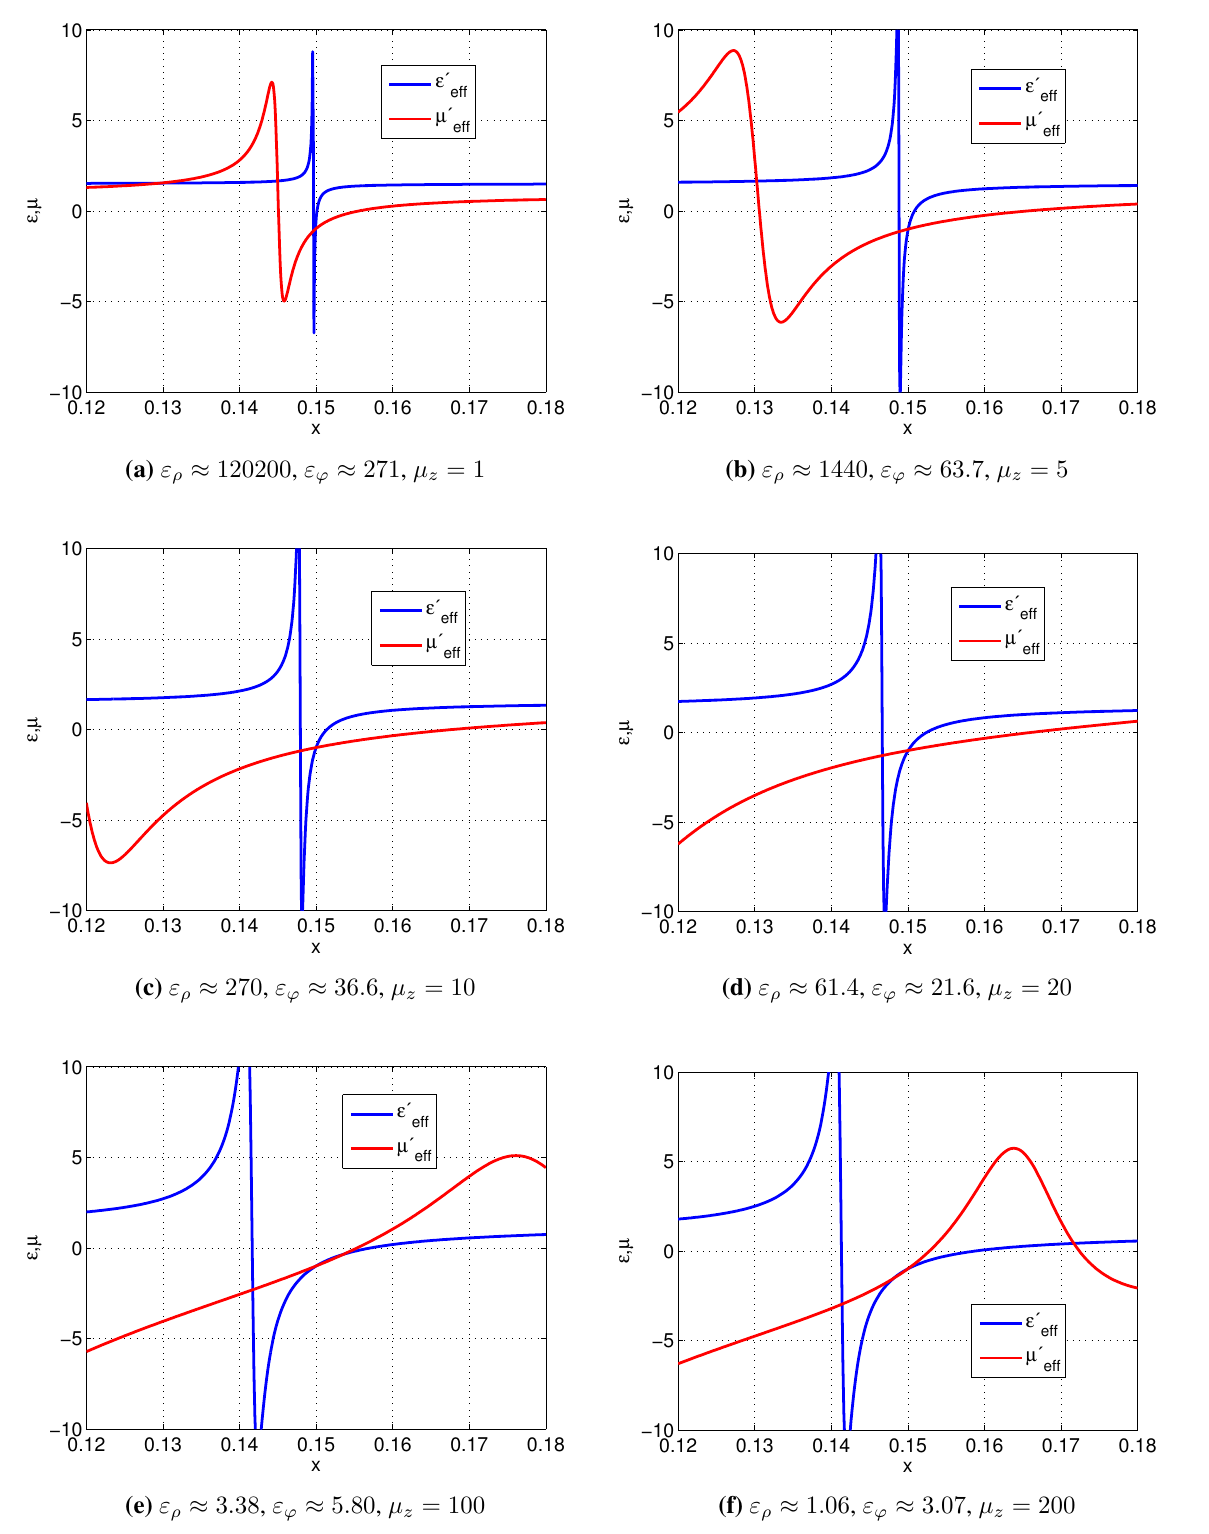
Figure 3. Effective parameters µ (cid:48) with area fraction p = 0 . 2 . All configurations 3a–3f yield ε (cid:48)